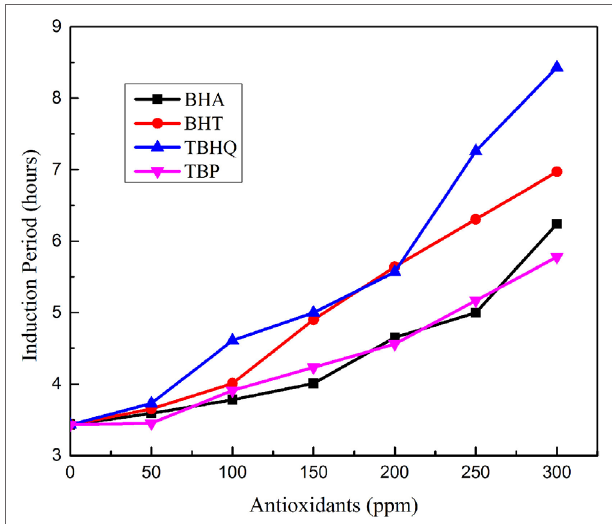
FigUre 1 | Variation in induction period of Tectona Grandis biodiesel with antioxidant